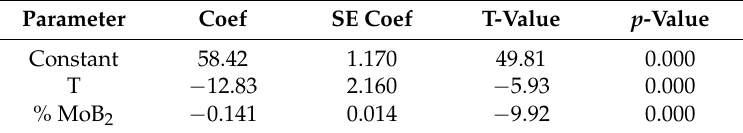
Table 2. Analysis of variance (ANOVA) of the model in Equation